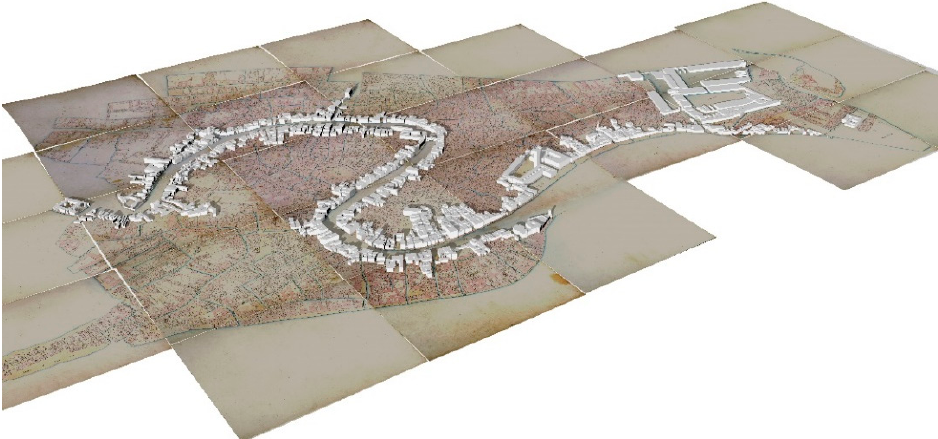
Figure 5. A bird’s-eye view of the City Model.